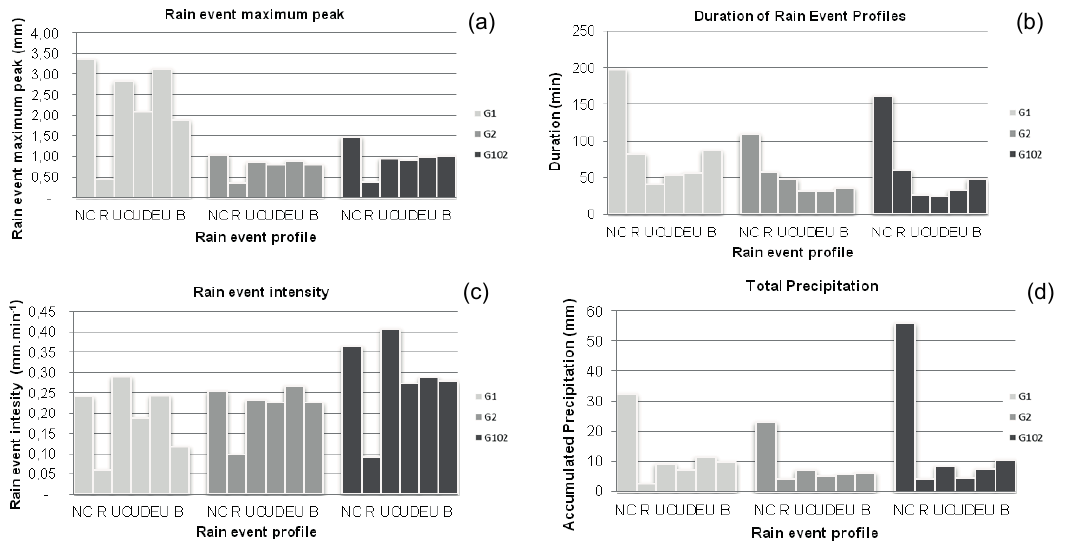
Fig. 6 Intergauge analysis of main characteristic of total rain event